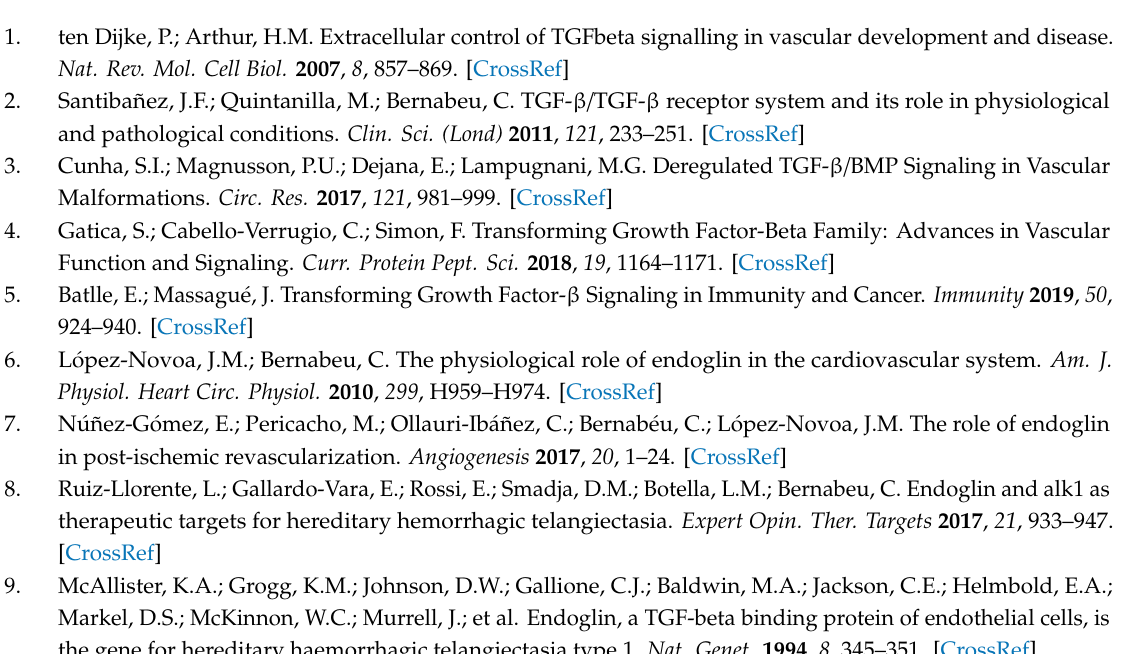
Figure S1: Scheme of the protein isobaric labeling of the HUVECs secretome; Table S1: Upregulated proteins upon sEng treatment; Table S2: Downregulated proteins upon sEng